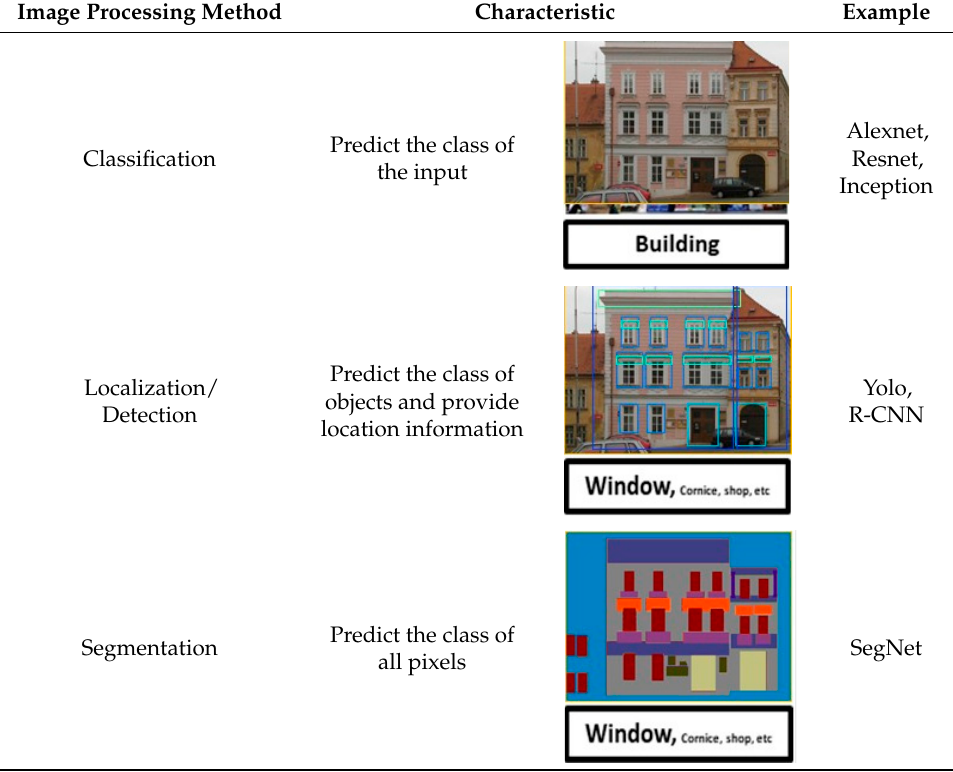
Table 3. Automatic labeling technology analysis. Image Processing Method